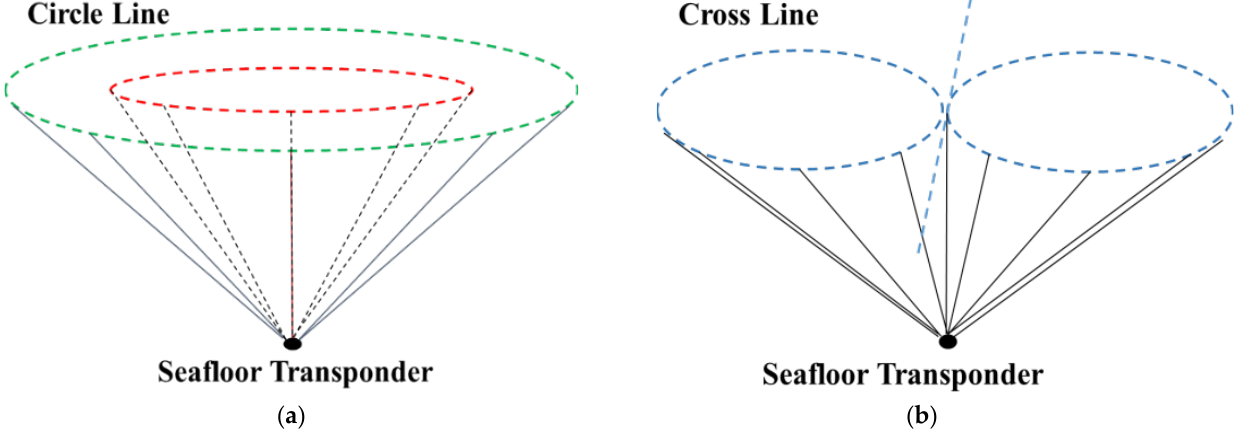
Figure 3. Calibration survey line. Two circles around the seafloor transponder ( a ). A figure eight with the seafloor transponder in the center ( b ).